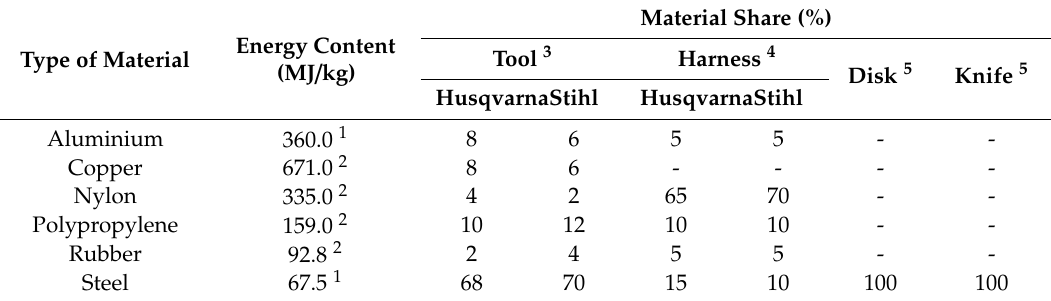
Table 2. Energy contents and share of materials incorporated into the base tools, harnesses, and active cutting